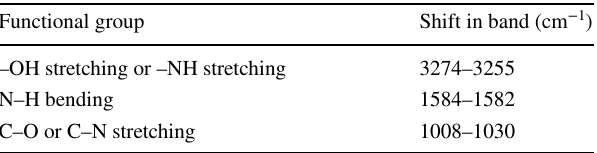
Table 8 Shifts in FTIR spectral bands and their responsible func- tional groups due to adsorption of MV2B on IA Functional